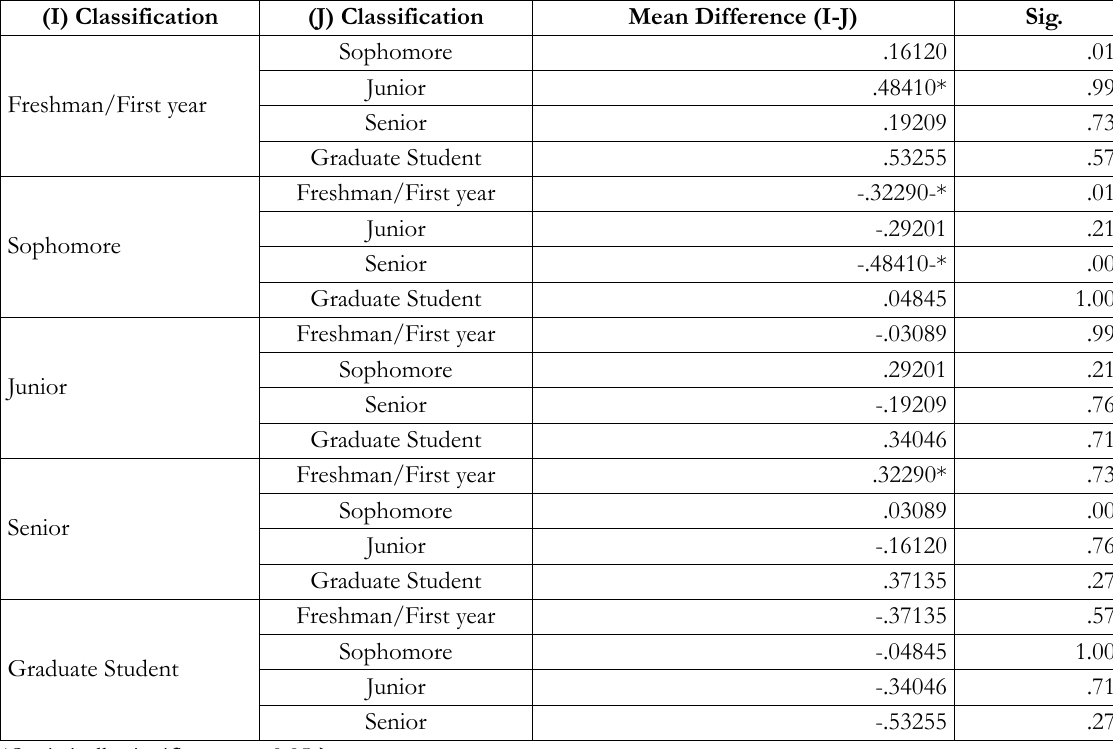
Table 12. The Scheffe test results to identify the source of the differences in the students’ responses, according to the classification